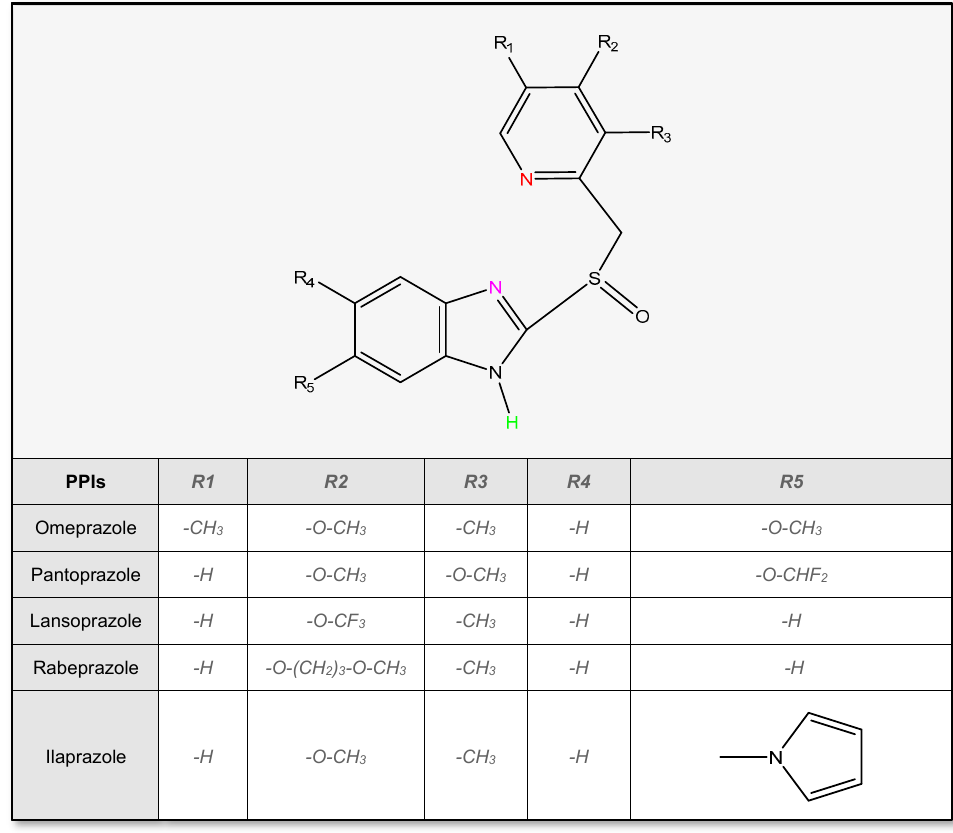
Figure 2. Chemical structure of proton pump inhibitors.